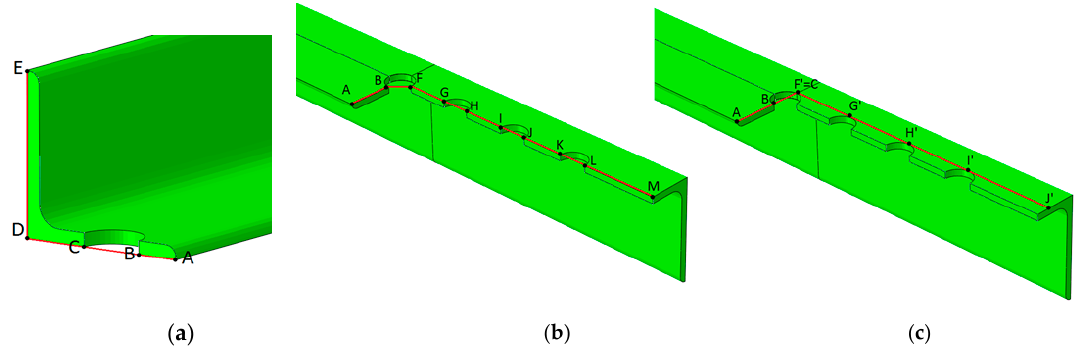
Figure 13. Fracture sequence obtained in FE modelling (specimen J8/2/55/40).